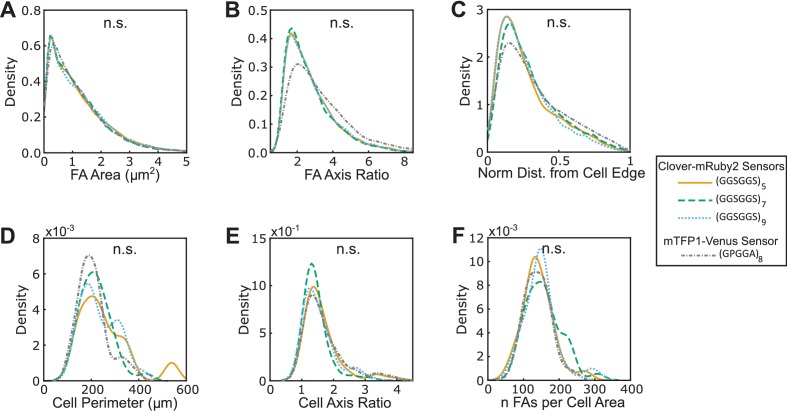
FA morphologies, cell morphologies, and sensor localization to FAs are indistinguishable between different versions of VinTS.(A-F) Vin-/- MEFs expressing various version of VinTS show indistinguishable FA area (A), FA axis ratio (B), subcellular distributions of FAs quantified as normalized distance from cell edge (C), cell perimeter (D), cell axis ratio (E), number of FAs normalized by cell area (F). Different versions of the tension sensor include those constructed with minimal Clover-mRuby2 modules containing three distinct extensible domains, namely (GGSGGS)5 (n = 98 cells), (GGSGGS)7 (n = 79 cells), (GGSGGS)9 (n = 63 cells), along with the original TSMod containing a (GPGGA)8 extensible domain (n = 48 cells), each from at least three independent experiments; n.s. not significant (p≥0.05), ANOVA. See Supplementary file 4 for exact p-values.